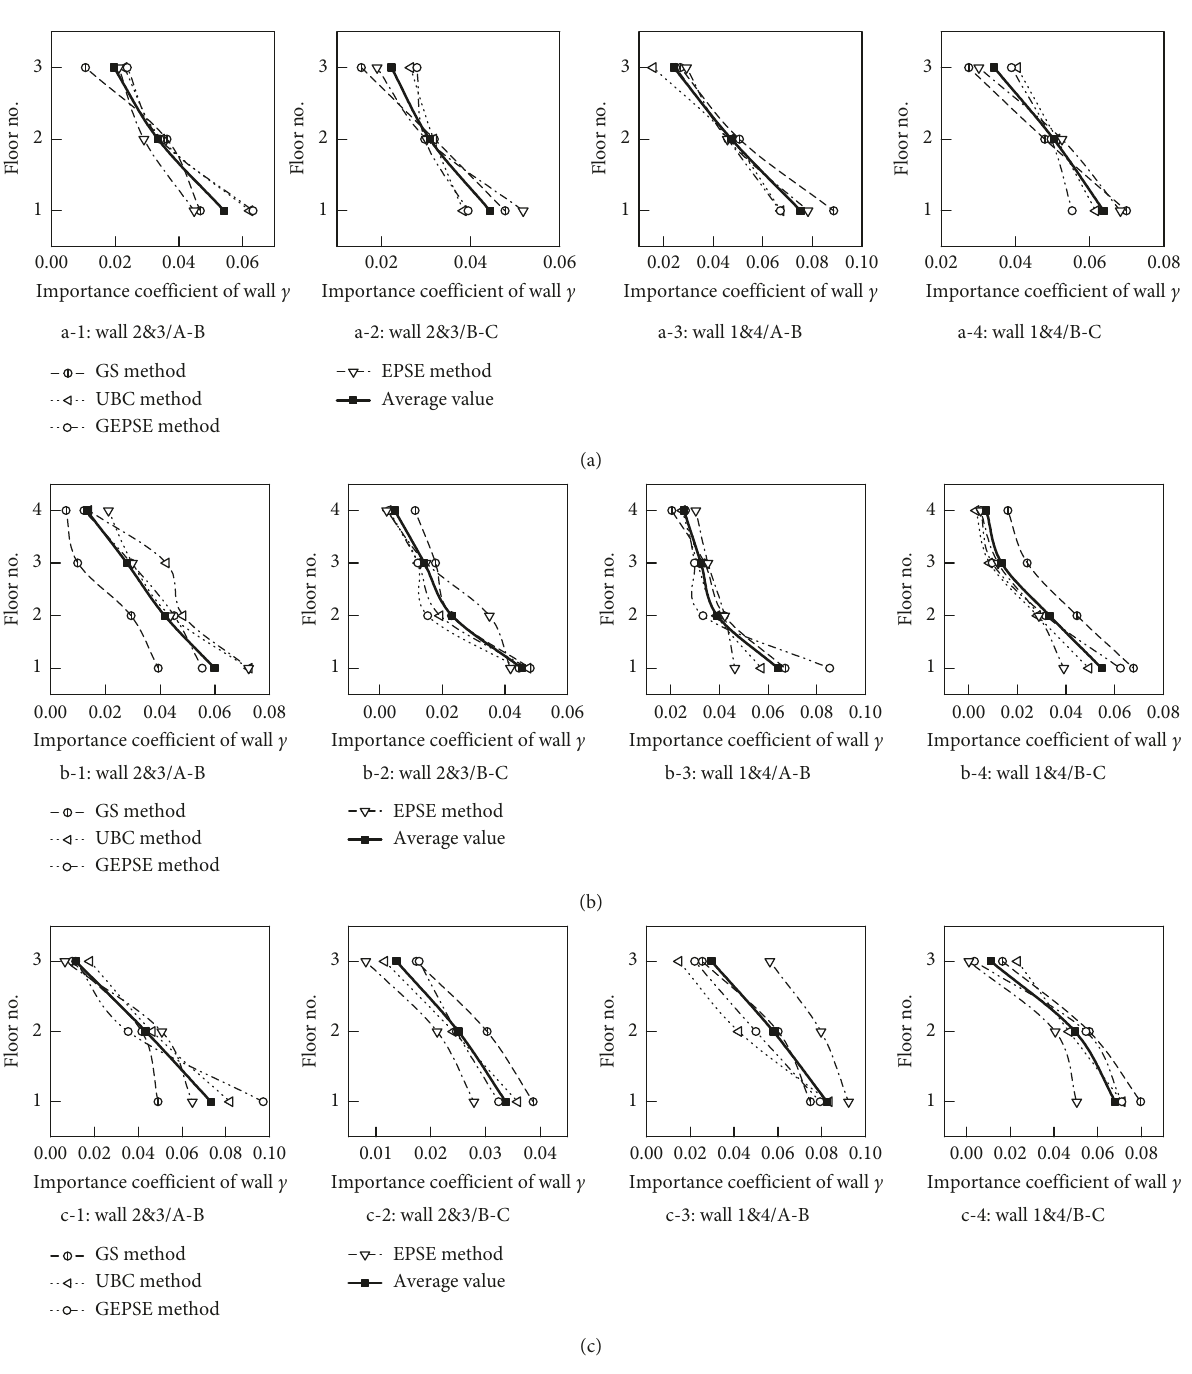
Figure 9: Variation curve of wall importance coefficient with floor. (a) Model MaS3-7 (0.1 g). (b) MaS4-7 (0.1g). (c) MaS3-8